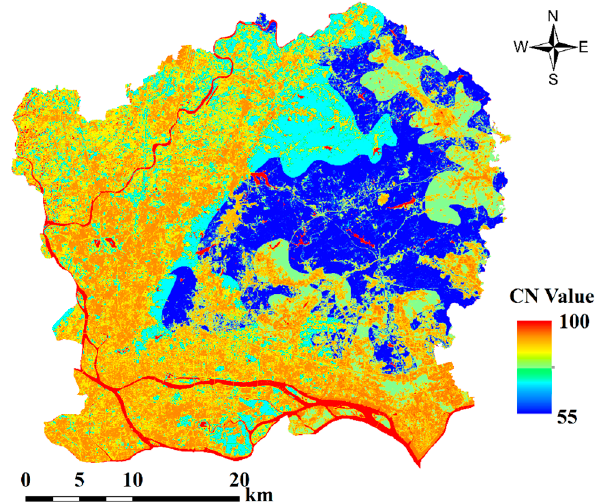
Figure 12. Composite CN map under the AMC II condition.